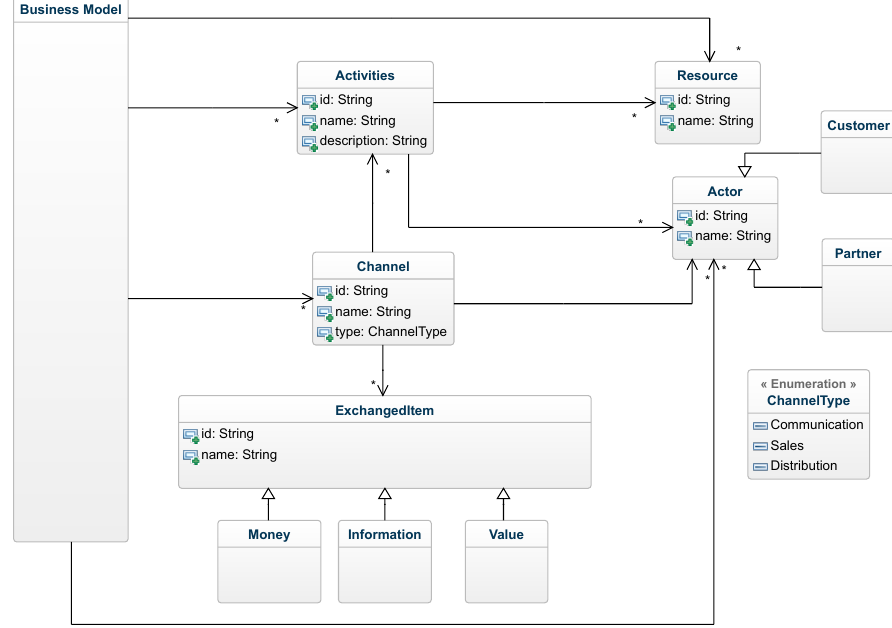
Figure 9. Business Model Preliminary